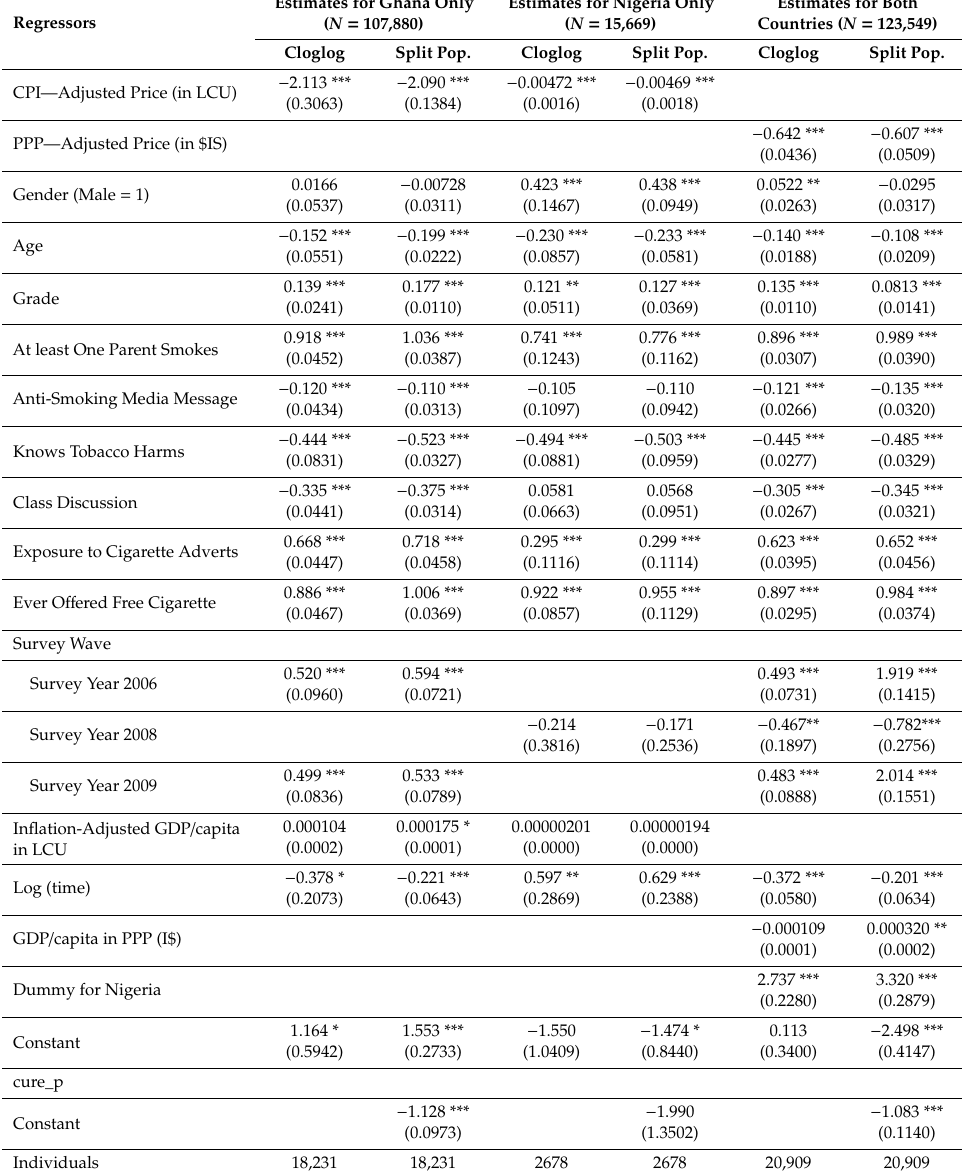
Table 5. Comparison of results from the complementary log-log (cloglog) survival models to that of split population survival models of tobacco use initiation among youth (ages 8–18) in Ghana & Nigeria (standard errors in